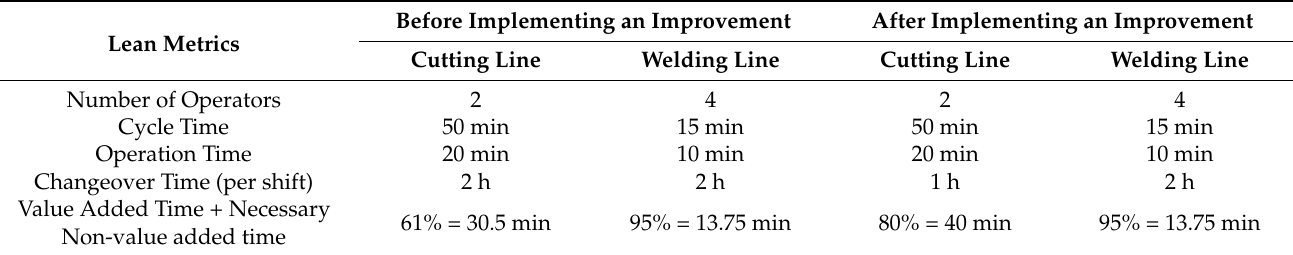
Table 5. Situation before and after the implementation of the